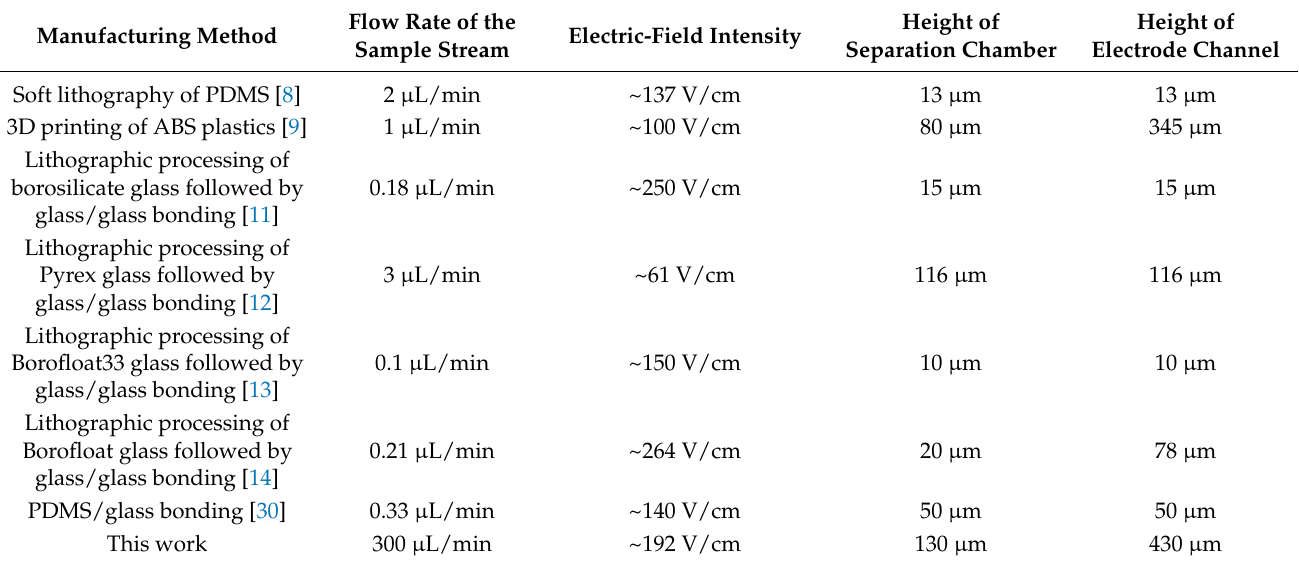
Table 1. Typical methods for the manufacture of µ FFE